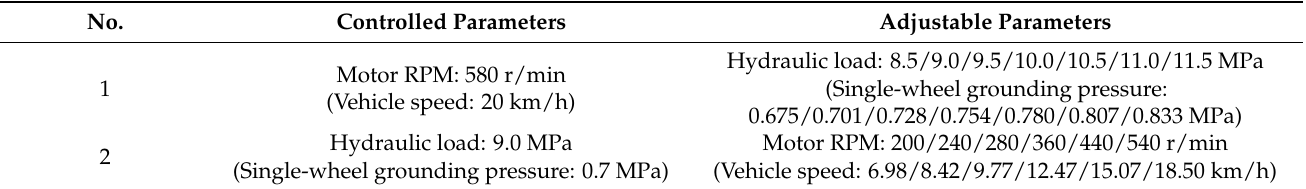
Table 3. Field test